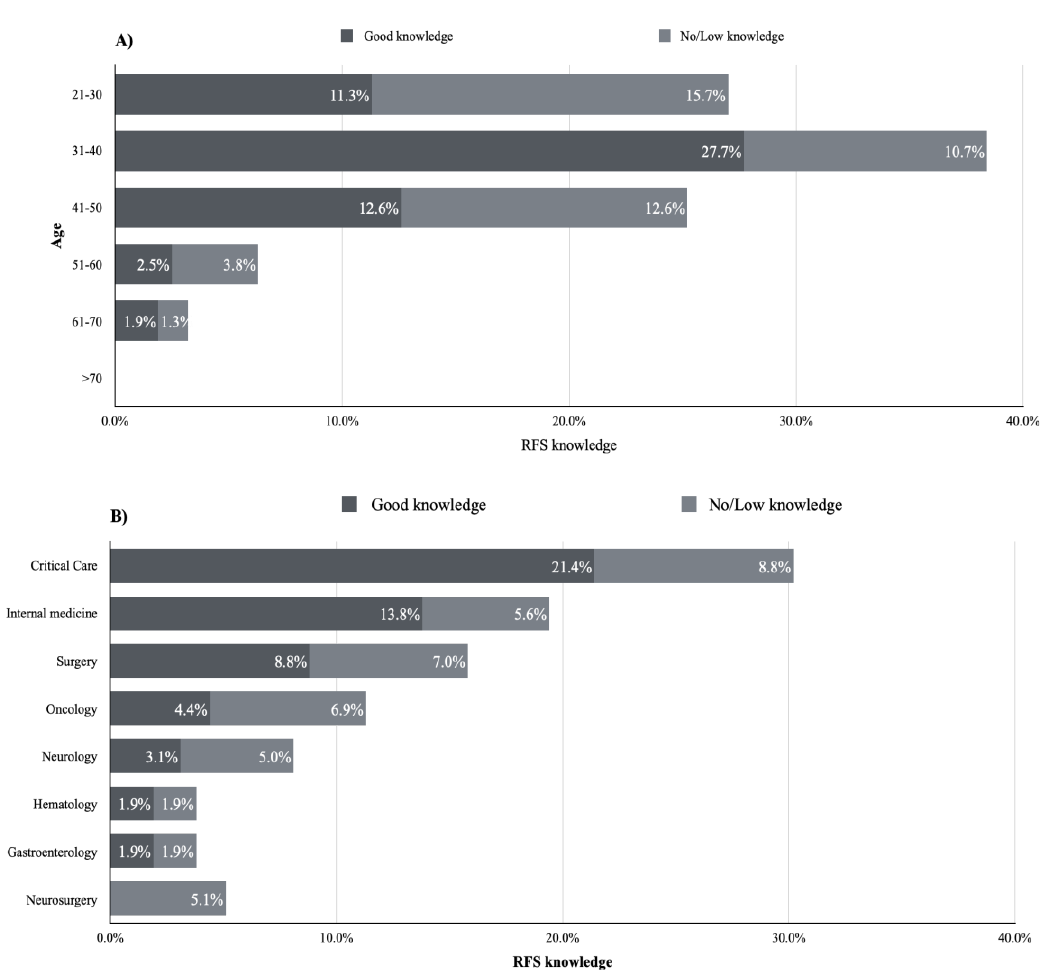
Figure 3. The factors influencing knowledge level among physicians at KAMC, ( A ) illustrates the in- fluence of age on RFS knowledge, ( B ) illustrates the influence of medical specialty on RFS